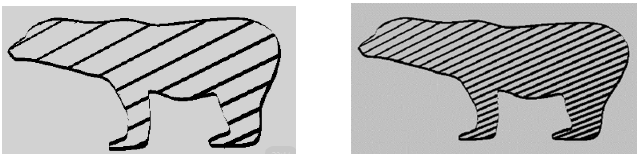
Figure 7. Linear patterns with various distance parameters.